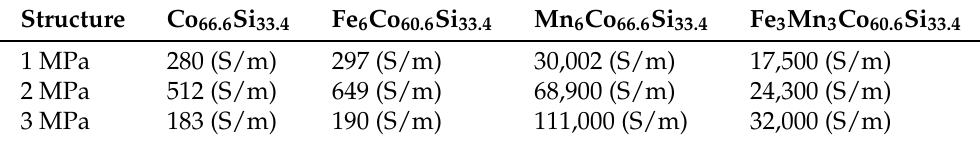
Table 3. Conductivities of as-prepared Co 66.6 Si 33.4 , Co 60.6 X 6 Si 33.4 , (X = Fe, Mn), and Co 60.6 Fe 3 Mn 3 Si 33.4 .